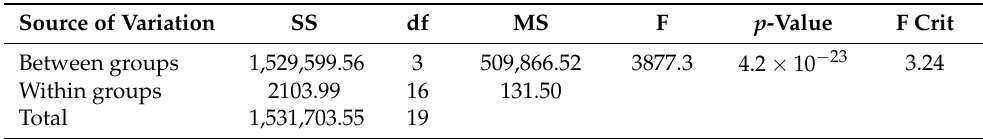
Table 10. Resulting ANOVA table for hybrid glass–carbon laminates under testing temperatures of 25–100 ◦ C.